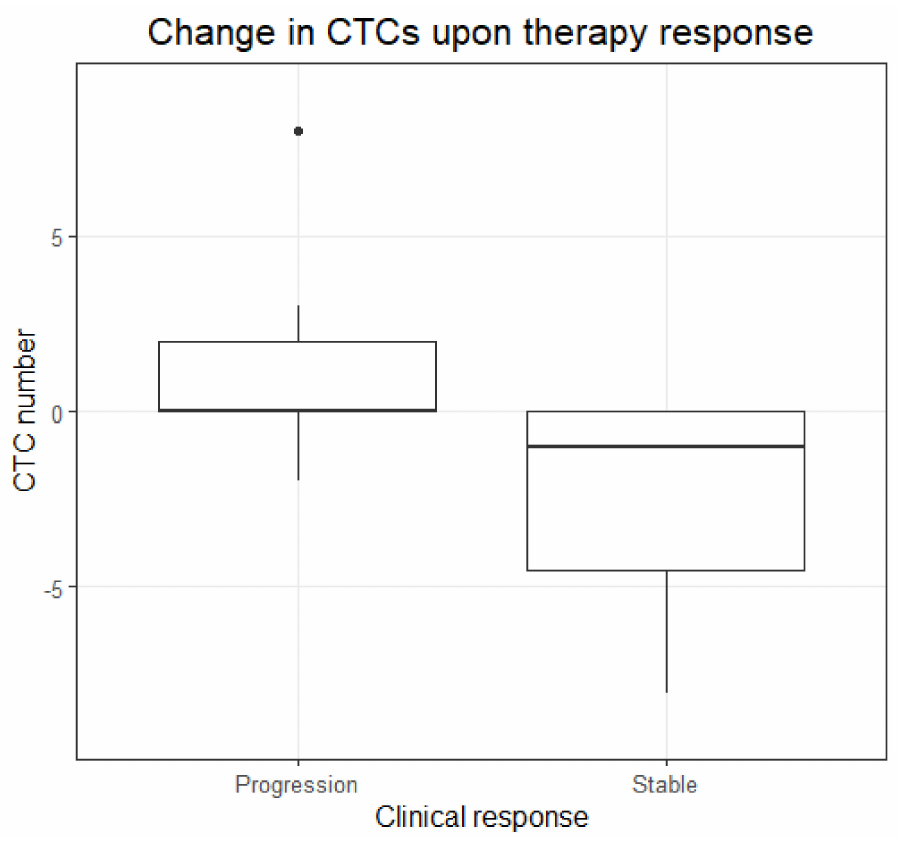
Figure 3. Change in CTC number. Boxplots showing the distribution of the change in the number of CTCs at progression of the disease ( n = 14) and at stable disease ( n =